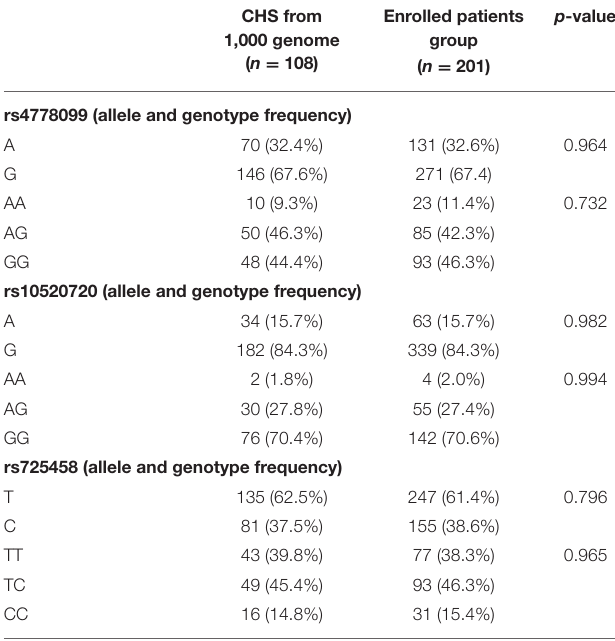
TABLE 2 | Allelic and genotypic frequencies of the target RGMa promoter SNPs in enrolled patient group and healthy subject group. CHS from 1,000